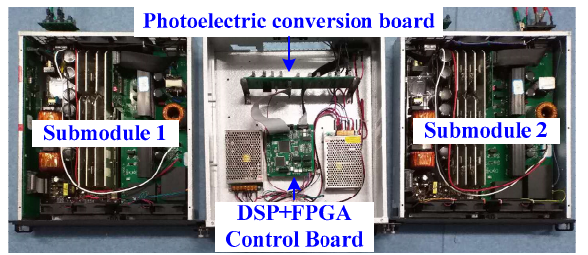
Figure 7. Diagram of the experimental prototype.